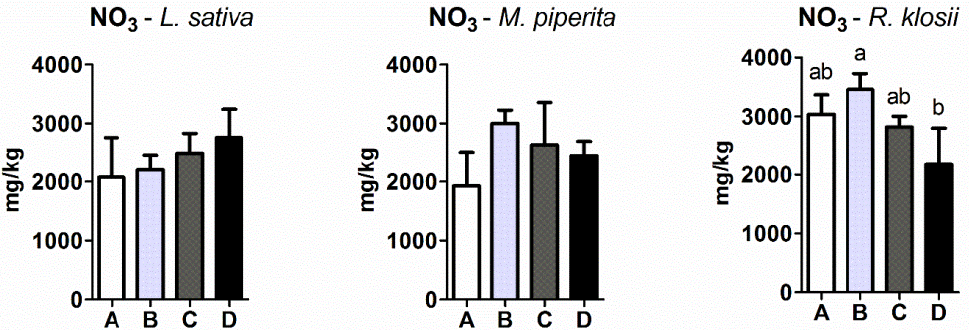
Figure 5. Nitrate content (mg kg −1 ) in lettuce, mint and mushroom herb leaves from the different experimental groups. Values are means ± SD. Different lower-case letters indicate significant differences (p < 0.05 ) ; n = 3.